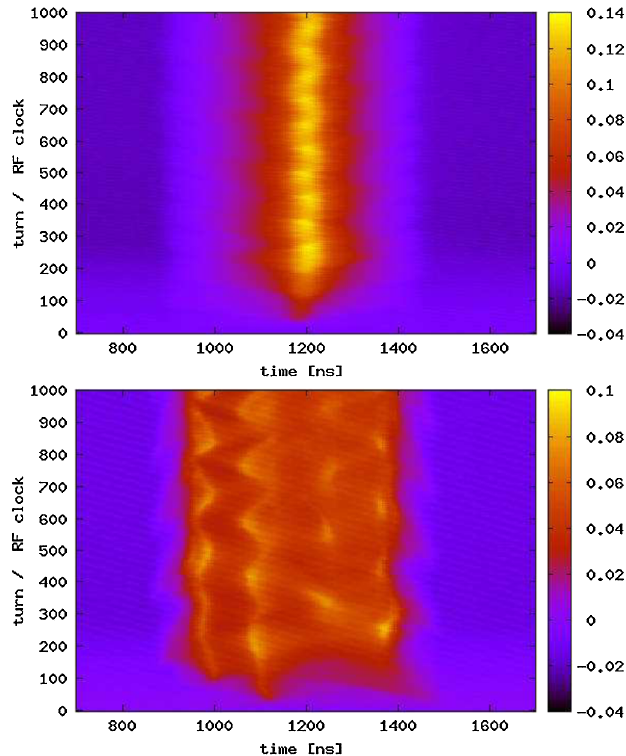
FIG. 30. (Color) Longitudinal beam profile mountain views measured for the injection period (0.5 ms) using WCM without (upper) and with (lower) the longitudinal beam